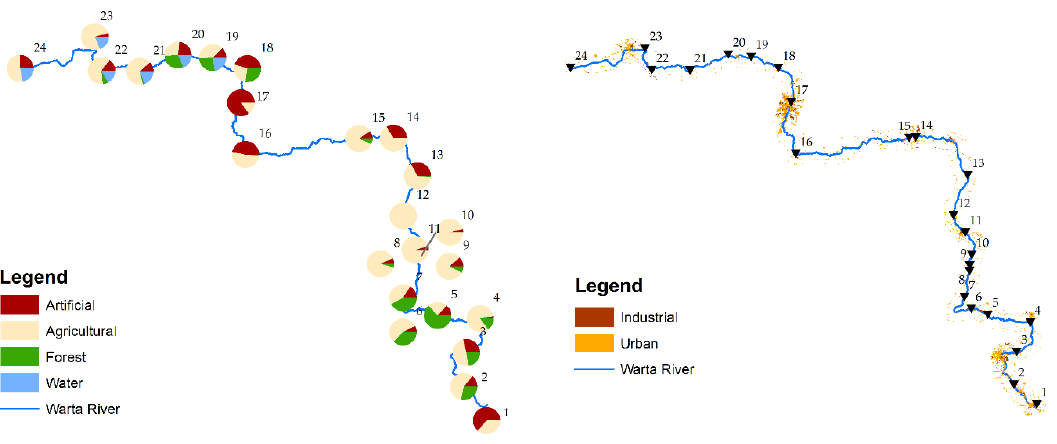
Figure 13. Land cover analysis.